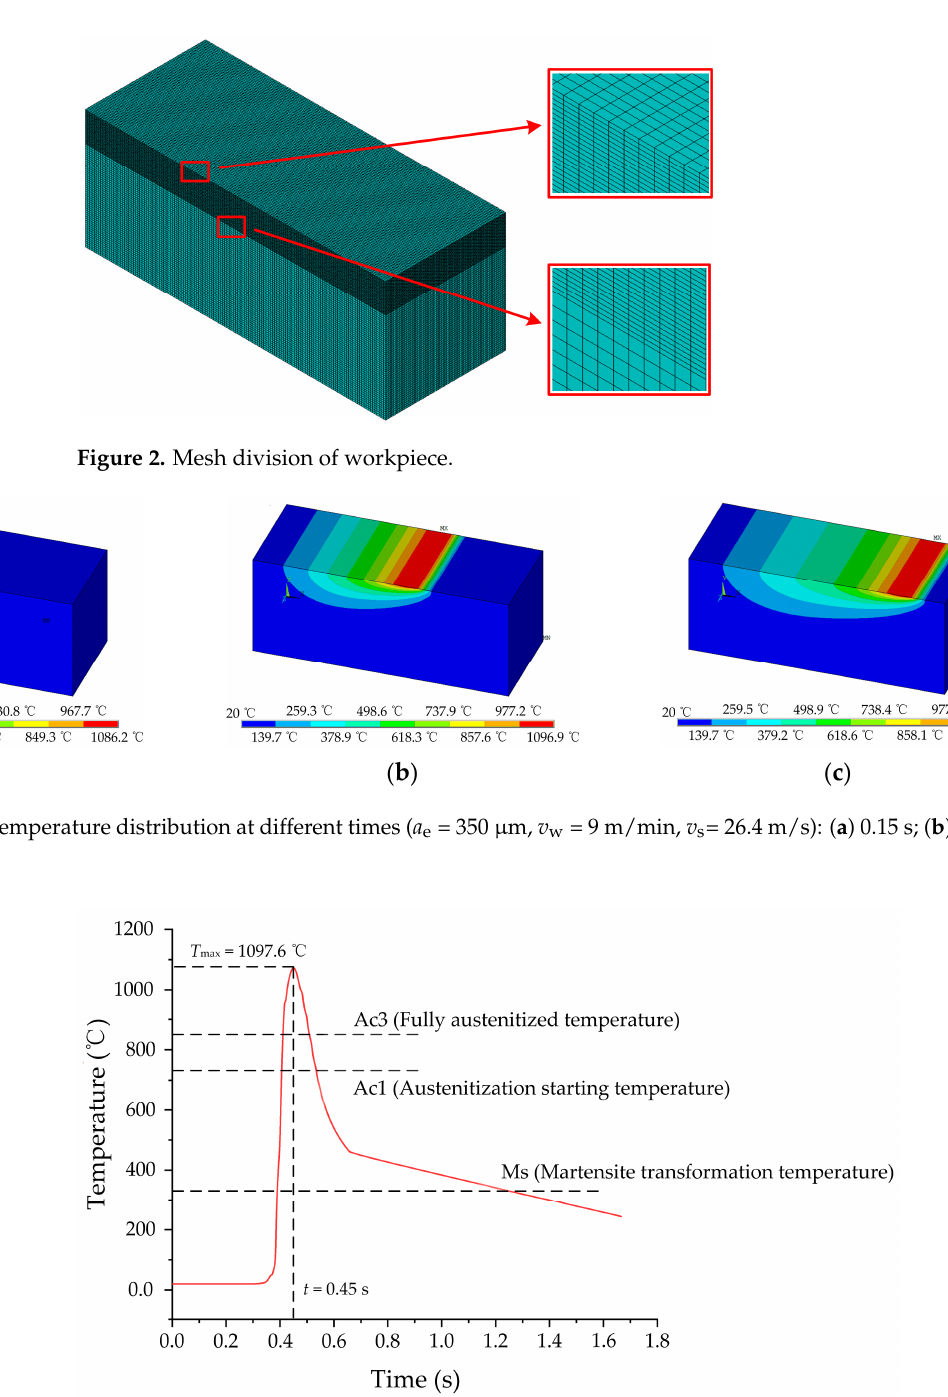
Figure 4. The instantaneous variation of grinding temperature.